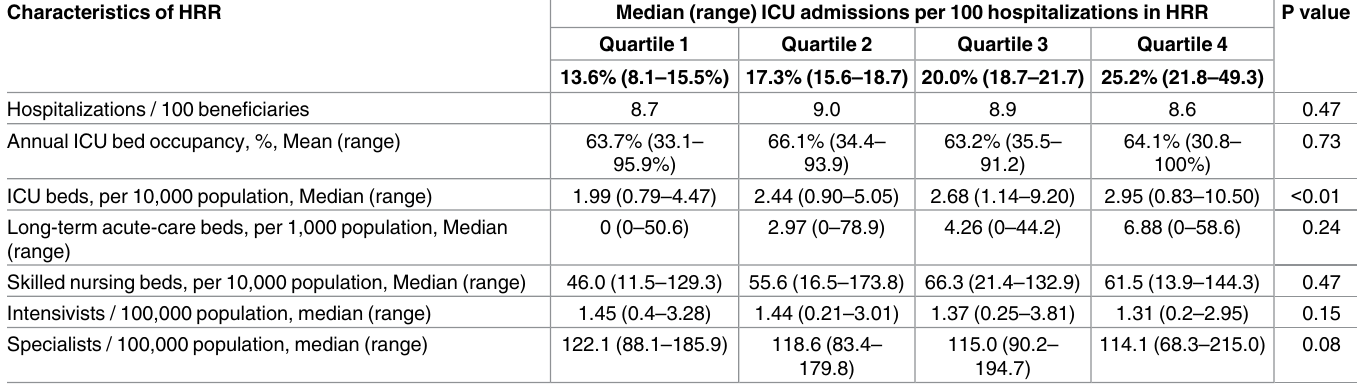
Table 2. Availability of regional resources.